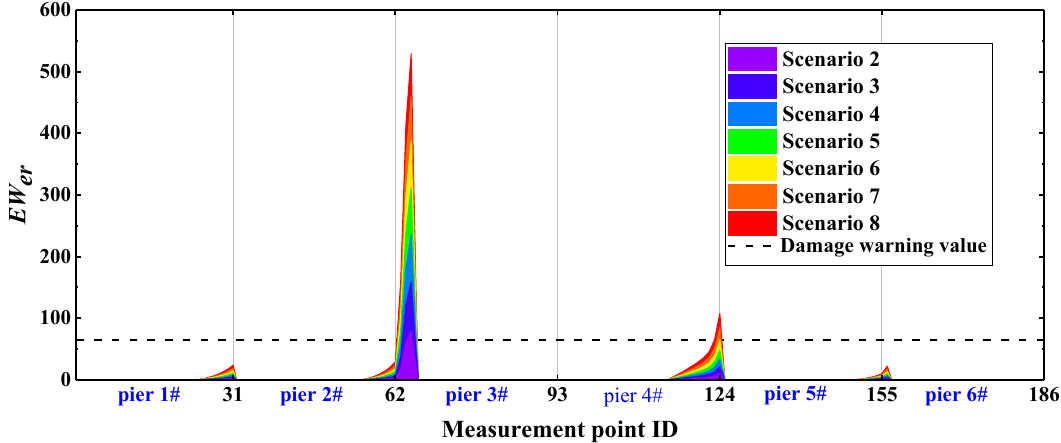
Figure 16. EW er identification results of damage I of 6 bridge piers.